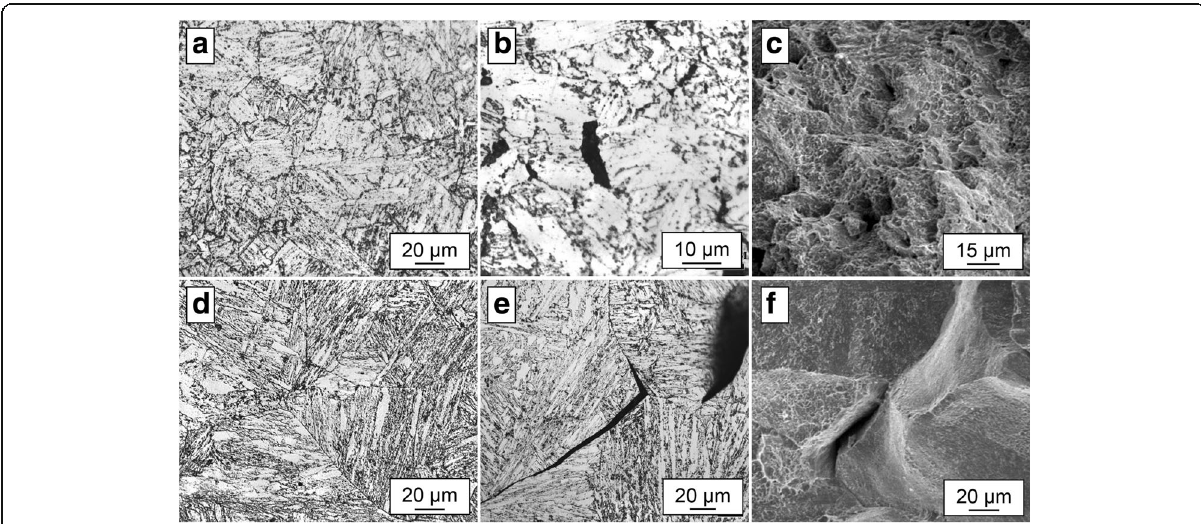
Fig. 4 The structure ( a , b , d , e ) and fracture ( c , f ) of the base metal 10XN3MD after tempering 600 °C ( a ) and simulated on Gleeble-3800 coarse-grained region of the HAZ and of steel 10XN3MDF after heating to 600 °C and tempering 1350 °C ( g ) and after deformation at a speed 5.5×10 − 6 s − 1 at a temperature of 600 °C ( b , c , e , f ), the base metal ( b , c ), and the coarse-grained region ( d , f